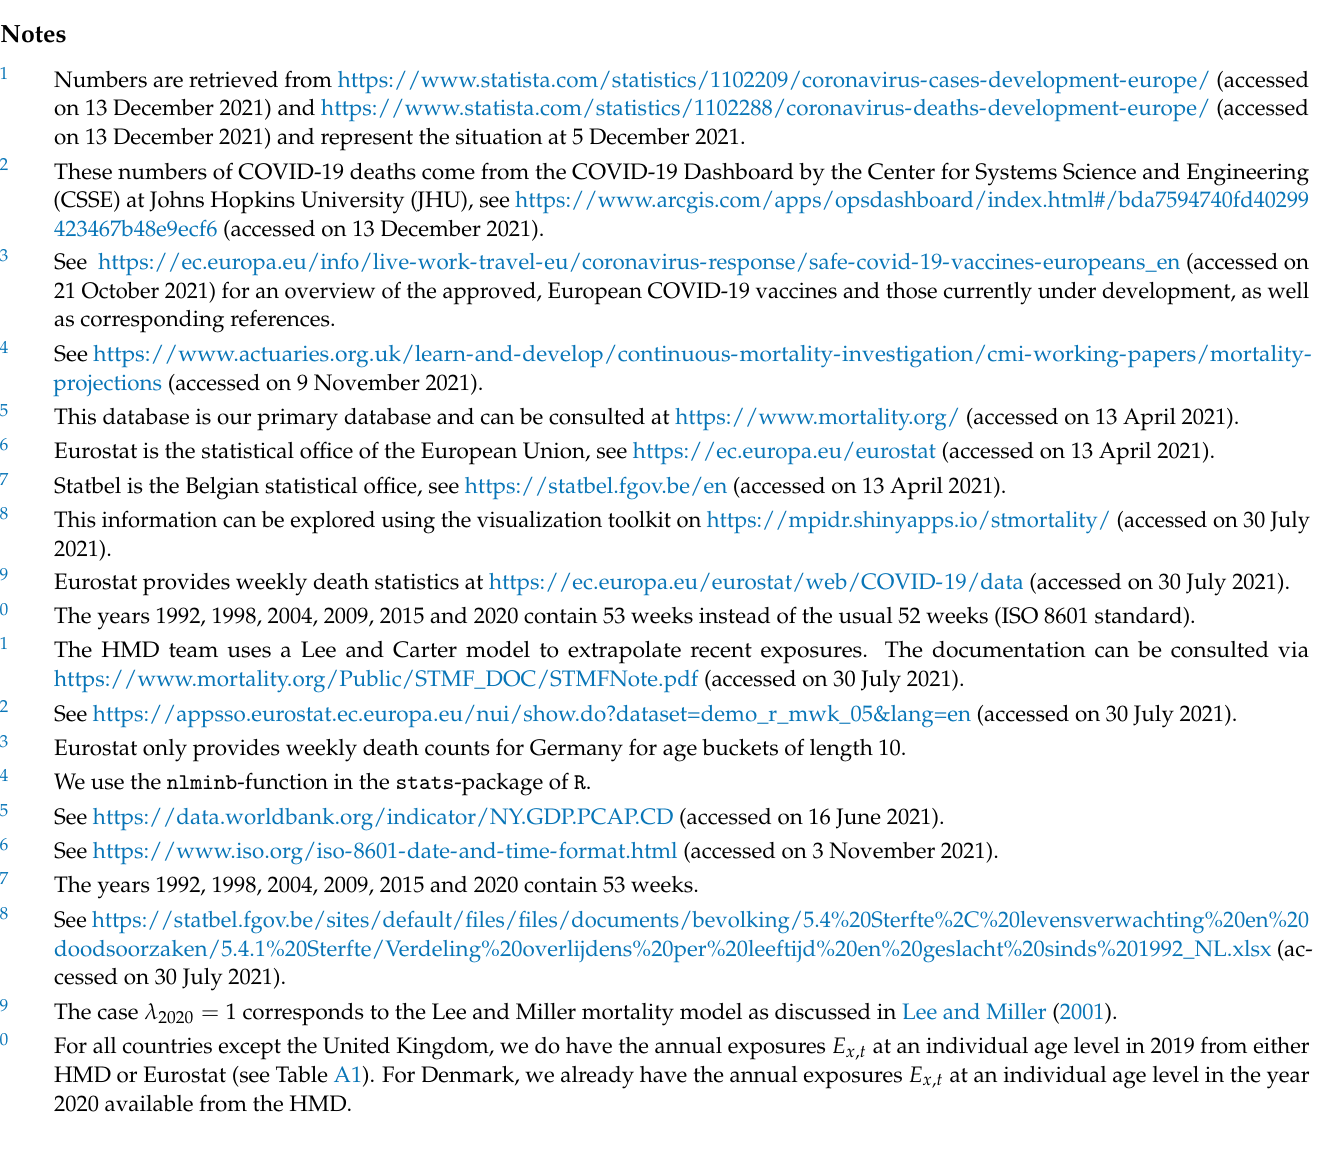
Figure A6. Validating the protocol to construct virtual death counts in the year 2020 for Belgium ( left ) and Denmark ( right ) from the weekly death counts collected in age buckets from